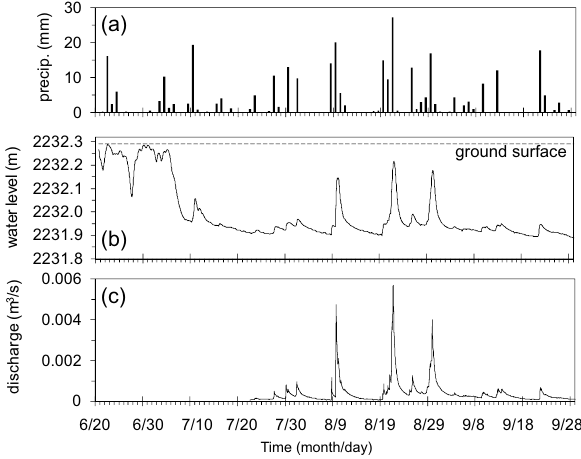
Fig. 10. Hydrological data for June–September, 2008. (a) Daily precipitation. (b) Elevation (above mean sea level) of the water level in piezometer P4. Dashed line indicates the ground surface at this location. (c) Discharge measured at the weir. See Figs. 3a and 9 for the location of P4 and the